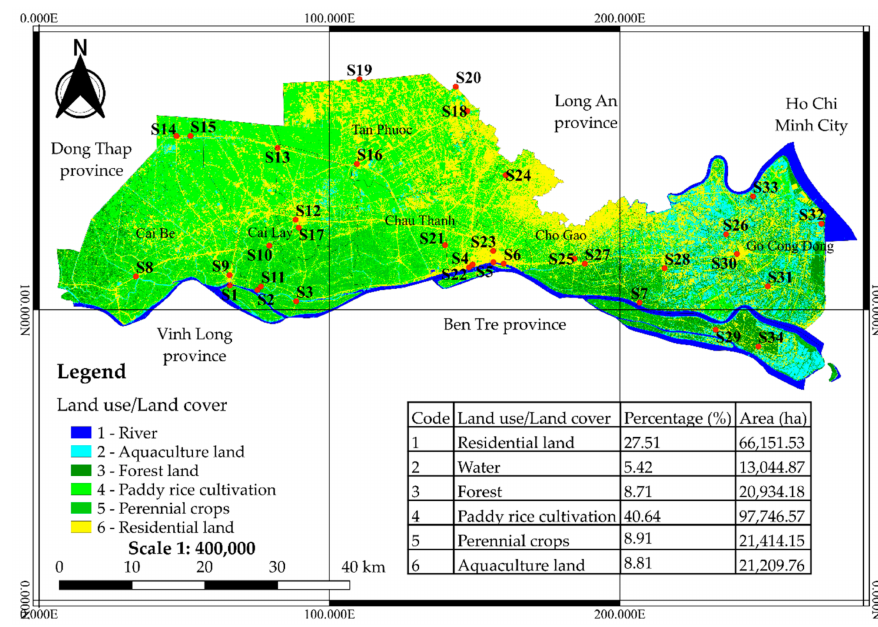
Figure 2. Land use distribution/land cover in Tien Giang in